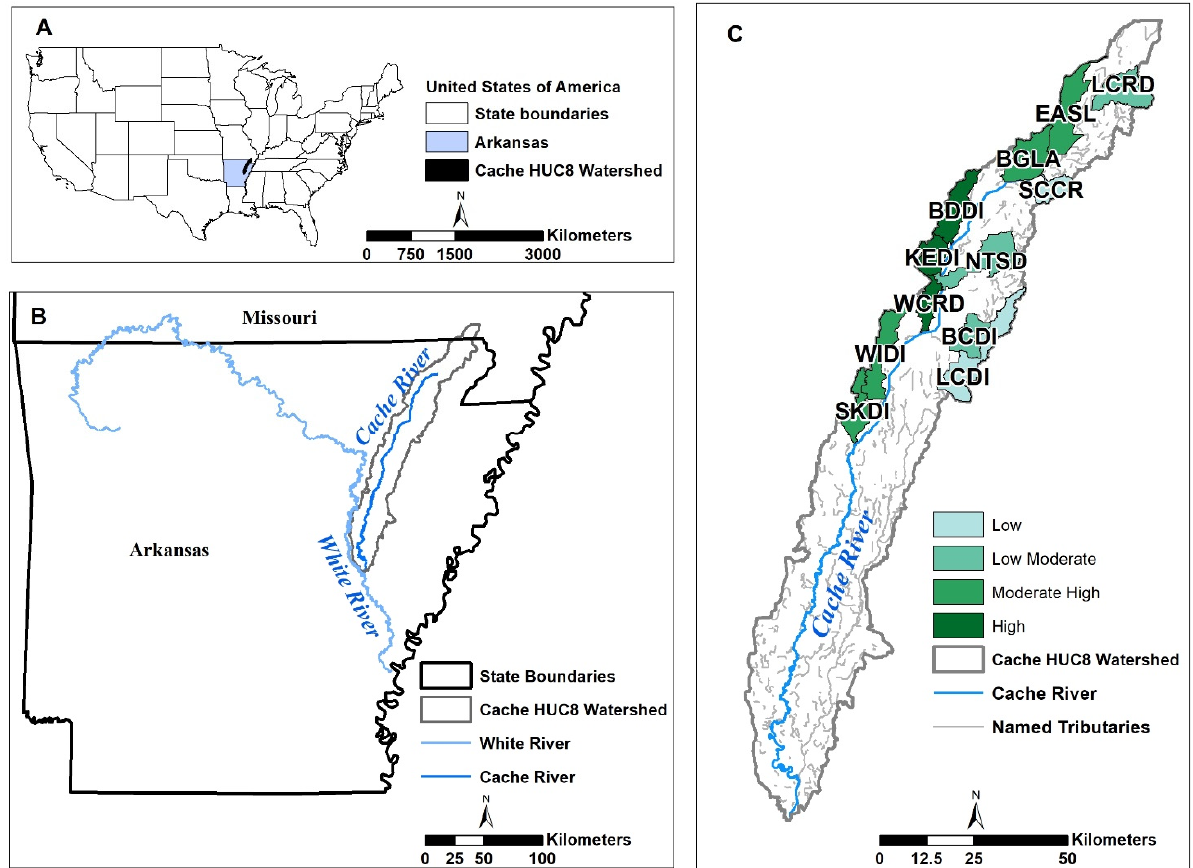
Figure 1. Location of the Cache River Watershed within Arkansas ( A ), the confluence of the White and Cache rivers ( B ), and agricultural intensity of sampled subwatersheds ( C ).